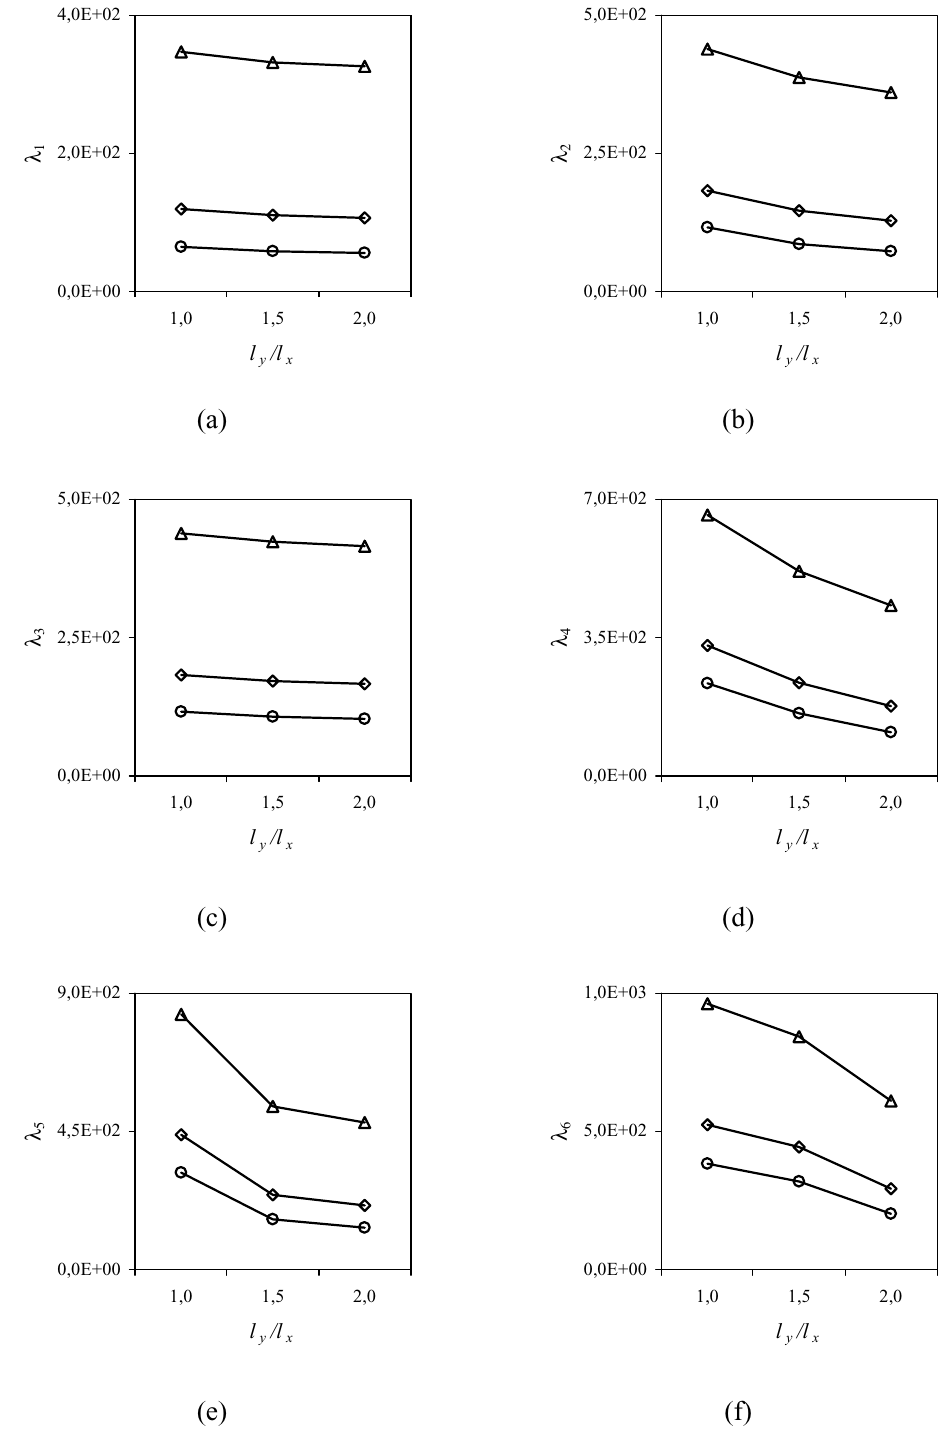
Fig. 5. The variation of the first six frequency parameters of the plate on elastic foundation with various values of l y /l x ratio and H for γ = 5 . – ∆ –, H = 5 m; – ♦ –, H = 10 m; –o–, H = 15